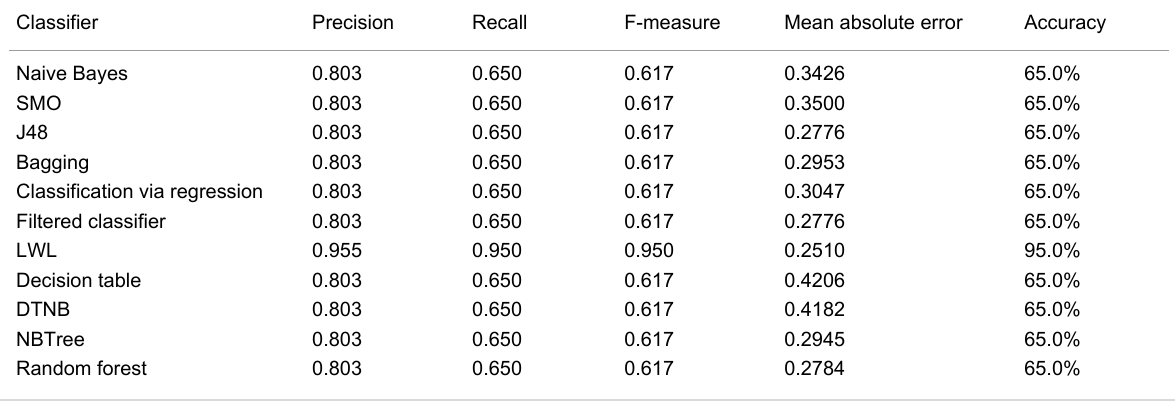
Table 5: Results from the external validation test set analysis listed by classifier using all molecular descriptors. See Equation 1–4 for the definition of precision, recall, F-measure, and mean absolute error and accuracy.